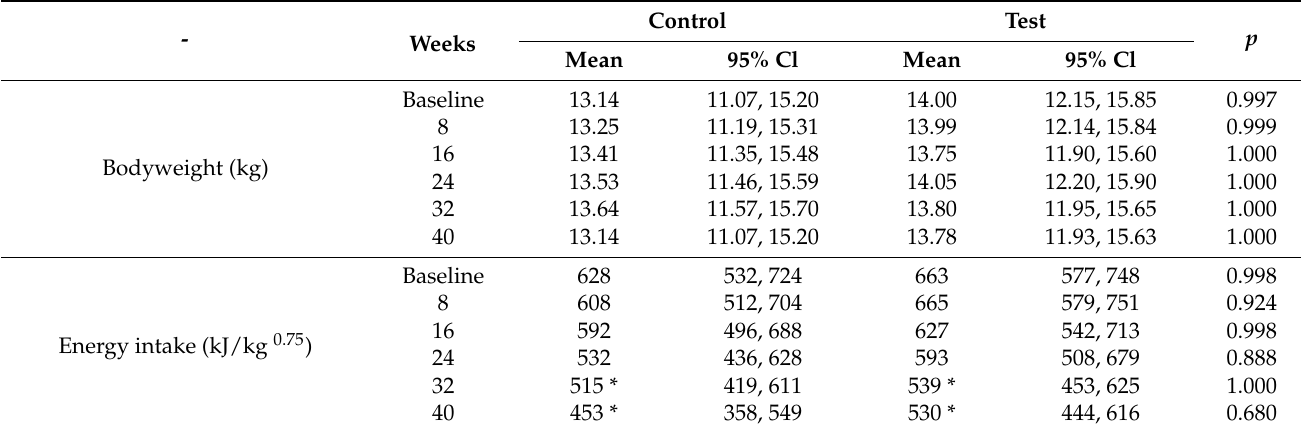
Table 2. Bodyweight, energy, calcium, and phosphorus intake values given as means and 95% confidence intervals (CI) for the control ( n = 8) and test ( n = 10) diet dog groups at baseline and at eight-week intervals. p -Values represent the comparison between diet groups at the sample collection time